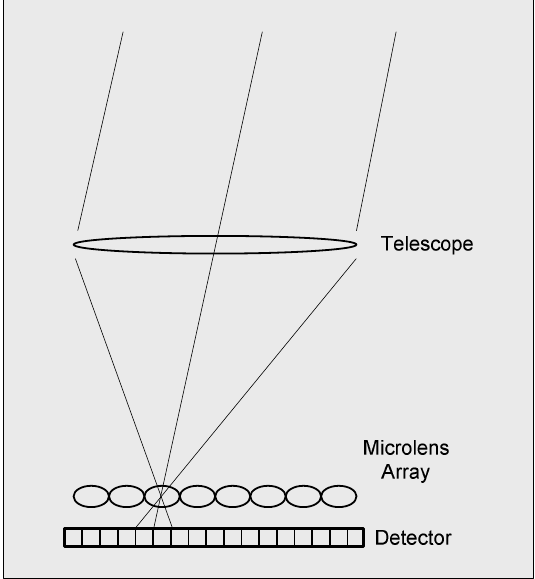
Figure 1. Outline of the Plenoptic camera used as wavefront